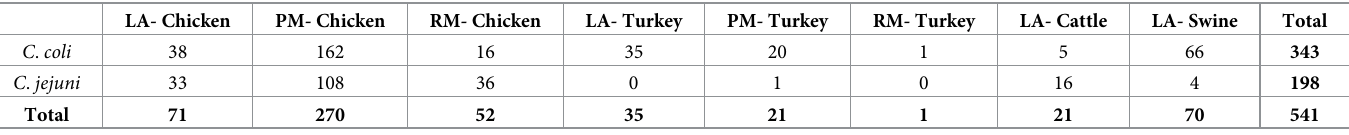
Table 3. North Carolina 2018–2019 Campylobacter spp . study dataset distribution by